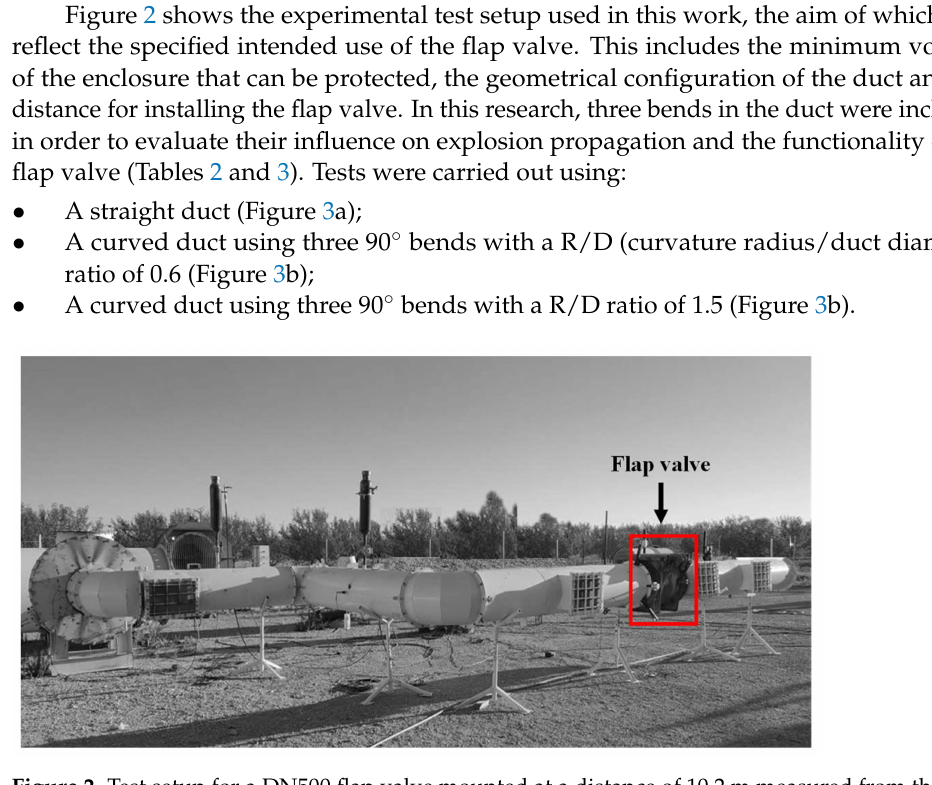
Figure 2. Test setup for a DN500 flap valve mounted at a distance of 10.2 m measured from the 1 m 3 vessel, in a duct with three short radius bends (R/D = 0.6). Table 2. Summary of the tests performed for the straight